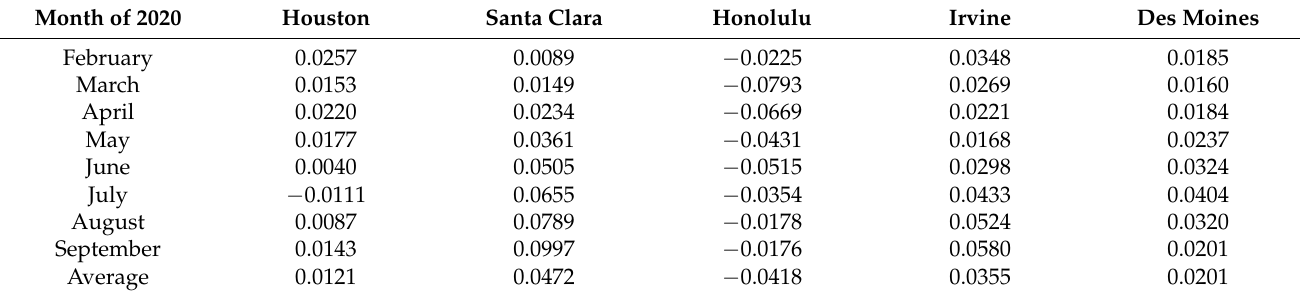
Table 3. Average Point Estimates for Figure